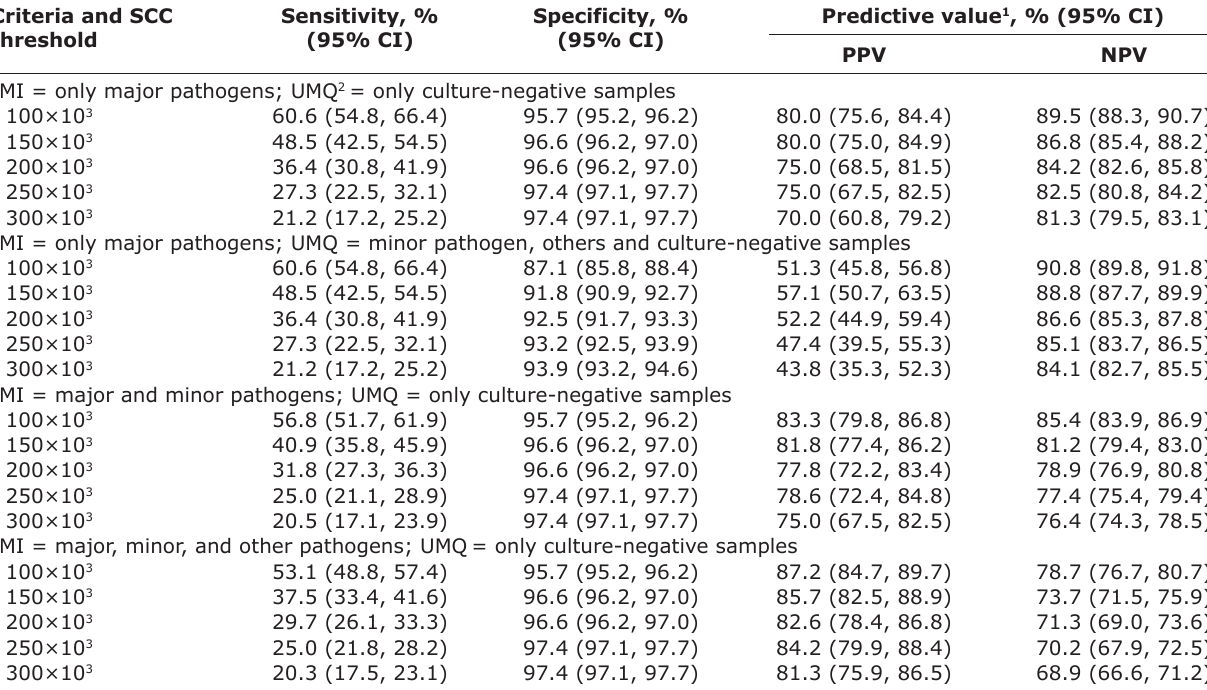
Table-1: Sensitivity, specificity, and predictive values (positive and negative) of five SCC thresholds (100-300×10 3 cells/mL) to identify IMI, considering three criteria of IMI of dairy cows. Criteria and SCC